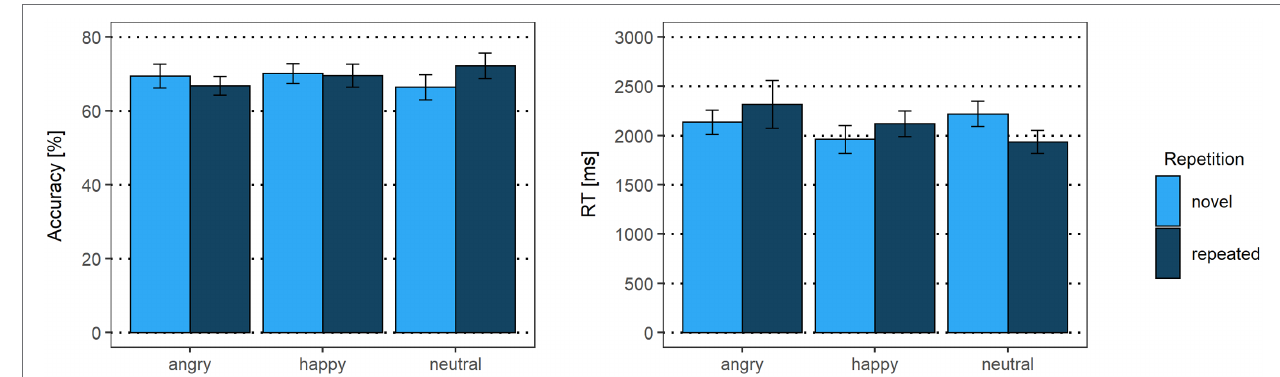
FIGURE 3 | Accuracy rates and reaction times of the delayed match-to-sample task. Error bars indicate standard errors (SE).